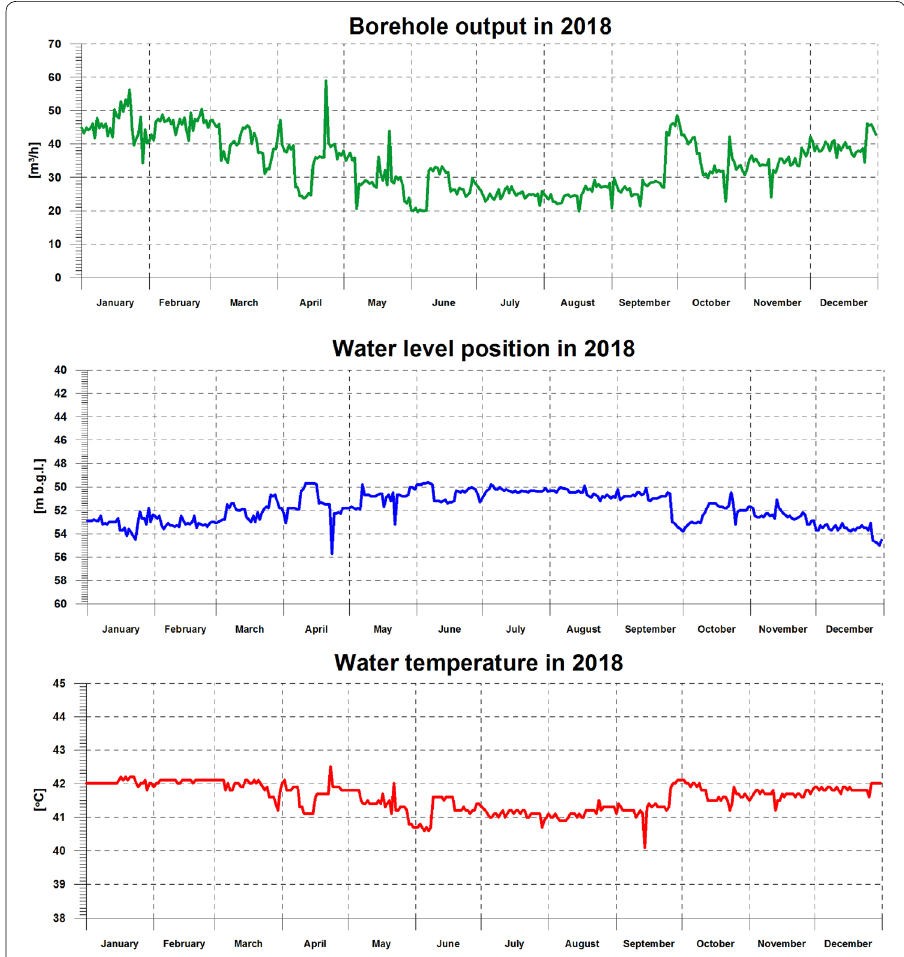
Fig. 9 Summary of monthly measurements of Mszczonów IG-1 geothermal well operation parameters (extraction rate, water table and water